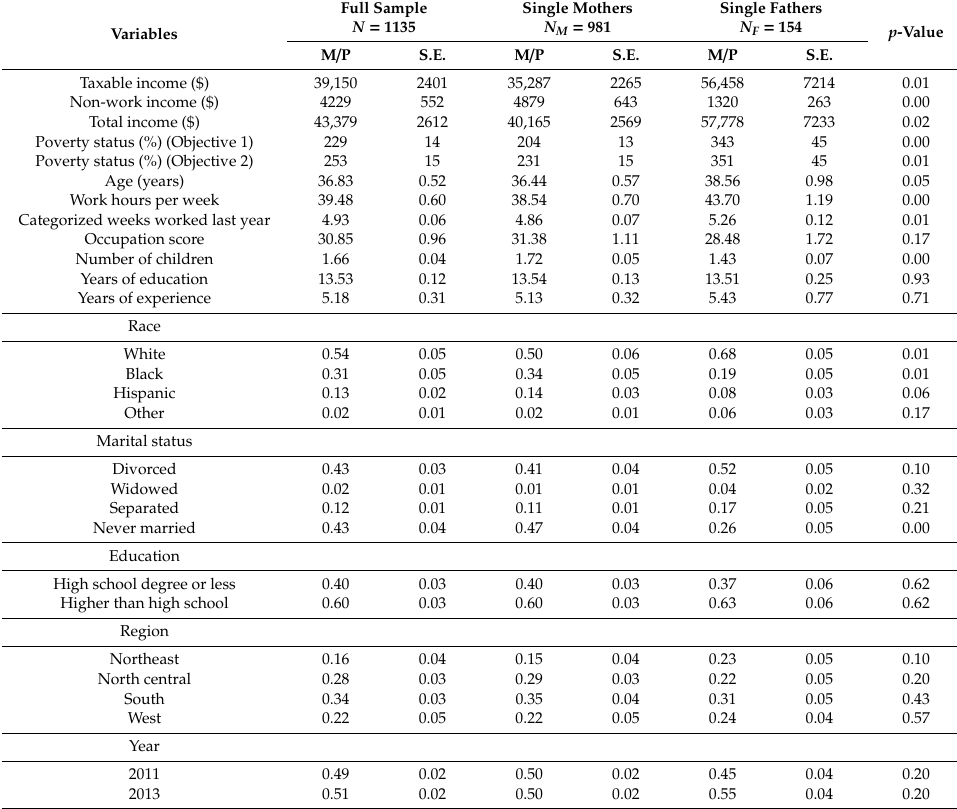
Table 1. Weighted means / proportions (M / P) and standard errors (S.E.) of dependent and independent variables (pooled Panel Study of Income Dynamics (PSID) 2011 and 2013) by single-parent status.